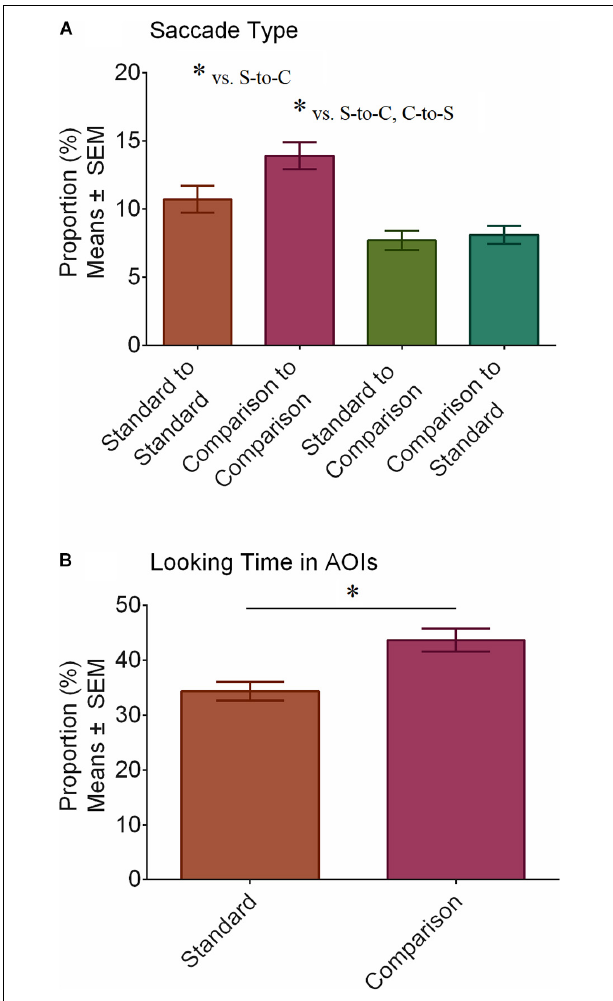
FIGURE 3 | Proportion of saccade types made and time spent looking at AOIs. Participants tended to make more saccades within than between the stimuli as denoted by the asterisks ( ∗ ) in panel A . Looking times were longer for the comparison compared to the standard stimulus, as shown in panel B . Asterisks ( ∗ ) denote significant differences after correcting for multiple comparisons using the Bonferroni method ( p < 0.05). S-to-C refers to standard-to-comparison saccades and C-to-S refers to comparison-to-standard